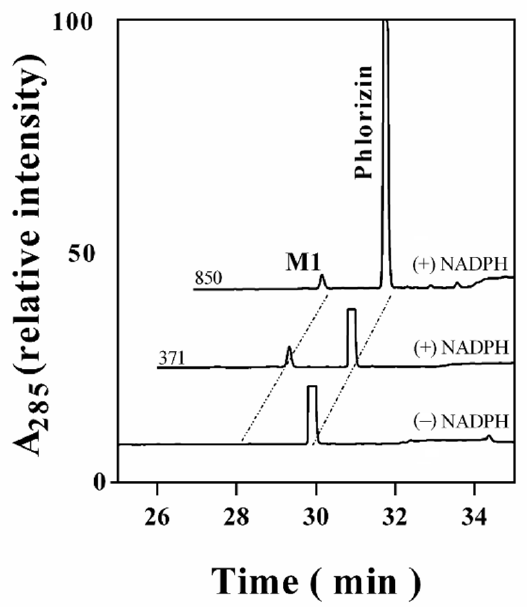
Figure 3. HPLC chromatogram of phlorizin and its products catalyzed by CYP102A1 mutants. The product peaks of reaction mixtures of HPLC traces were identified by comparing their retention times with that of phlorizin ( t R = 30.1 min). The retention time of product M1 was 28.2 min.